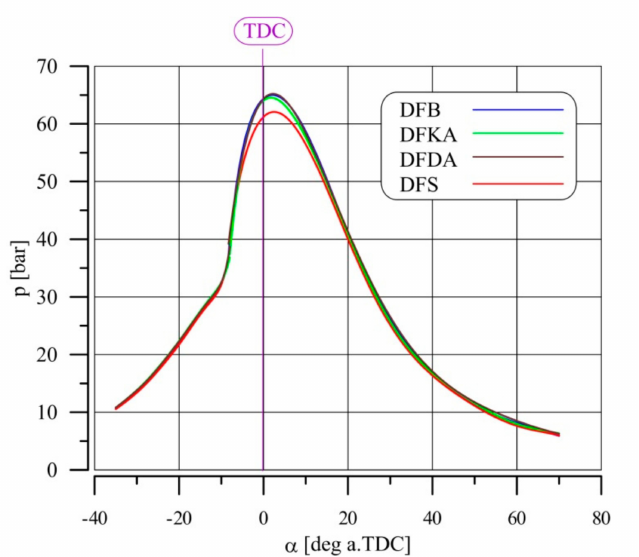
Figure 13. Pressure waveforms in engine cylinder powered by tested